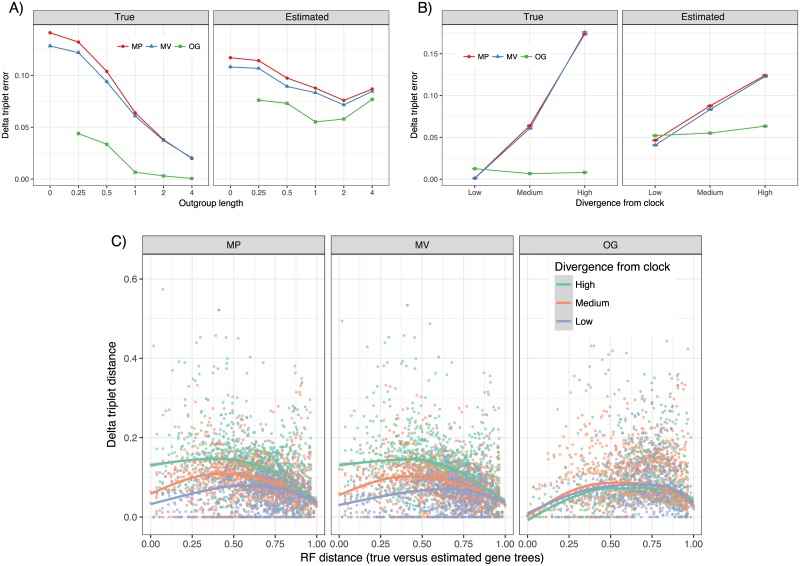
Rooting error above ideal rooting on 30-taxon dataset.Top: delta triplet error with both true and estimated gene trees for (A) medium divergence from the clock and varying R/C ratios and (B) R/C = 1 and varying levels of divergence from the clock. C: Delta triplet error versus gene tree estimation error, measured by RF distance, shown for high, medium, and low divergence from the clock; each point is an average of all gene trees in all replicates that had an identical RF gene tree error. A loess regression is fitted to the data using R.